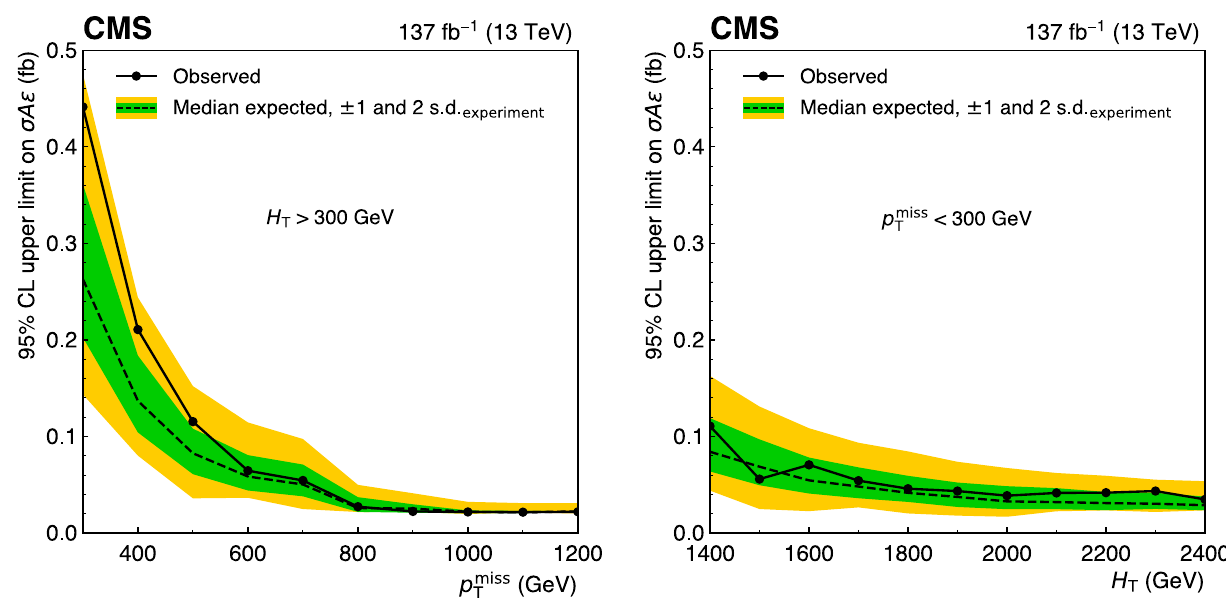
Fig. 13 Upper limits at 95% CL on the product of cross section, detector acceptance, and selection efficiency, σ A (cid:8) , for the production of an SS lepton pair with at least two jets, as a function of the minimum p miss < 300GeV p miss T